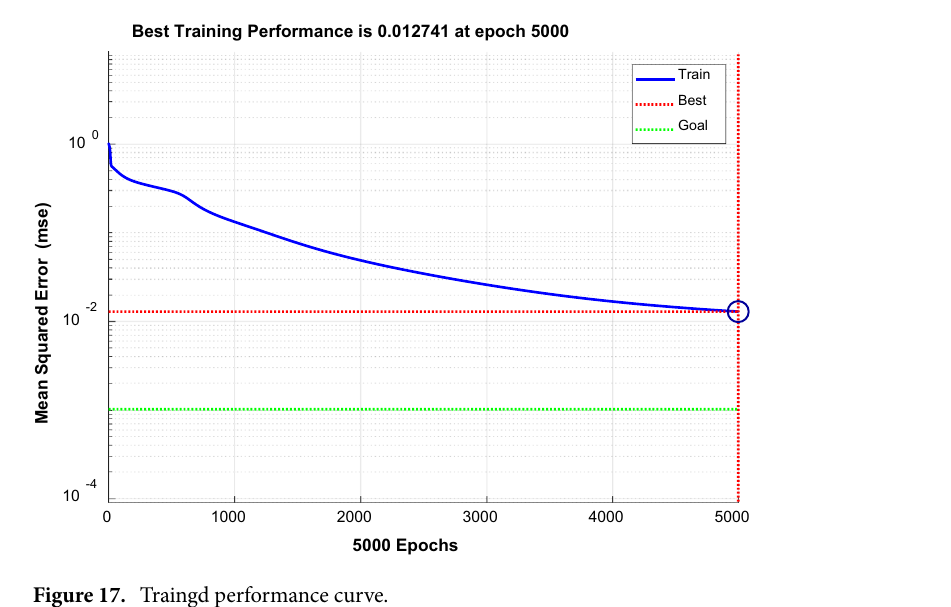
Figure 17. Traingd performance